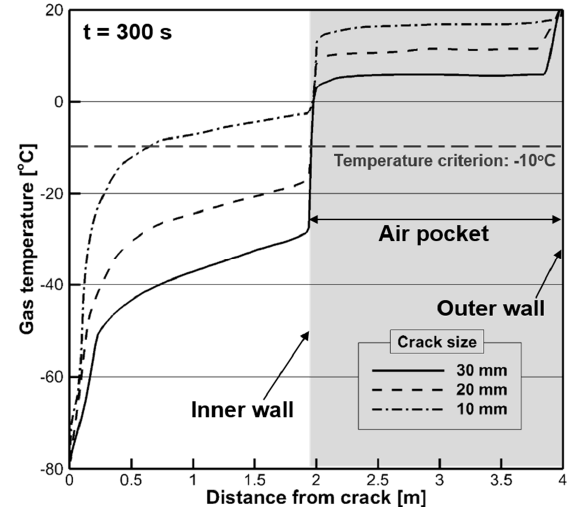
Figure 10. Gas temperature profile with respect to the distance from the crack.